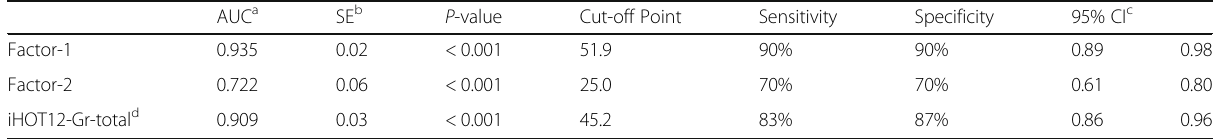
a The area under the ROC curve b The standard error of the area under the ROC curve c